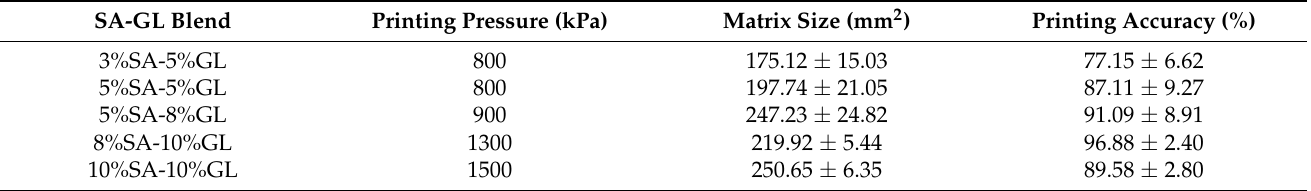
Table 1. Printing accuracy of different concentrations of sodium alginate/gelatine in printing